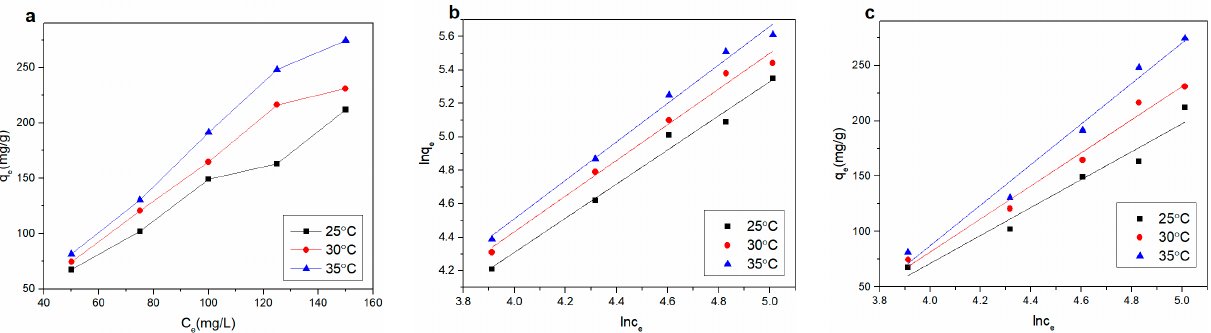
Figure 8. ( a ) Adsorption isotherms of Cu 2+ on rGO membrane at different temperatures; ( b ) Freundlich and ( c ) Temkin